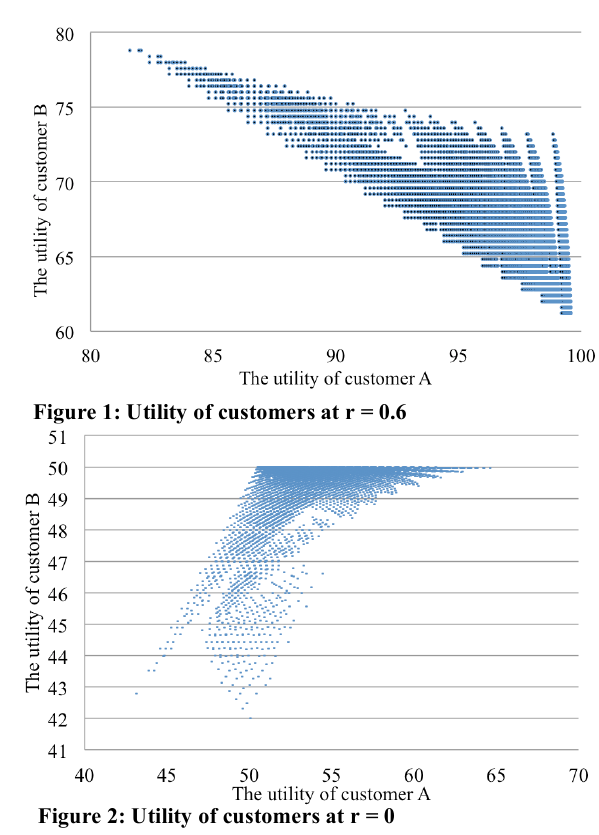
Figure 2: Utility of customers at r =